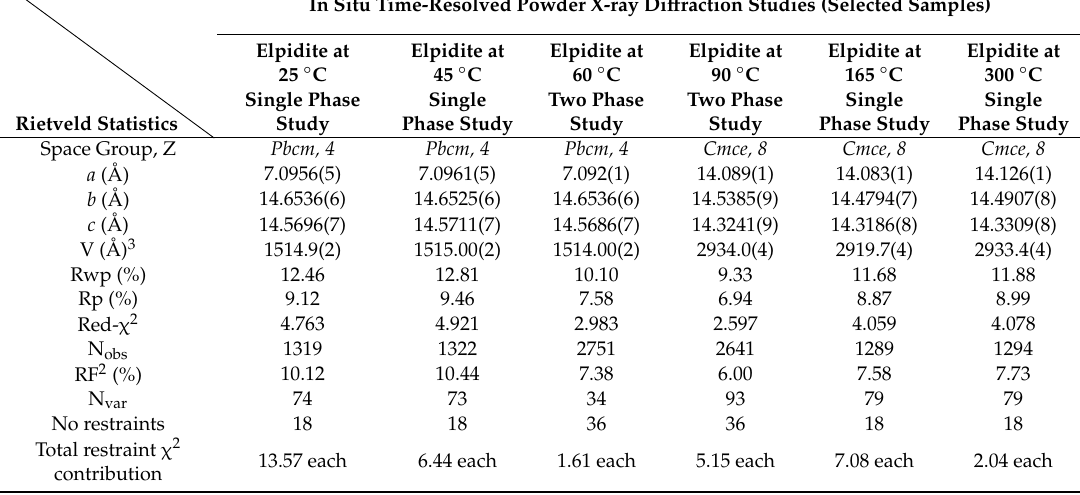
Table 1. Lattice parameters and refinement details for elpidite samples heated within the temperature range 25–300 ◦